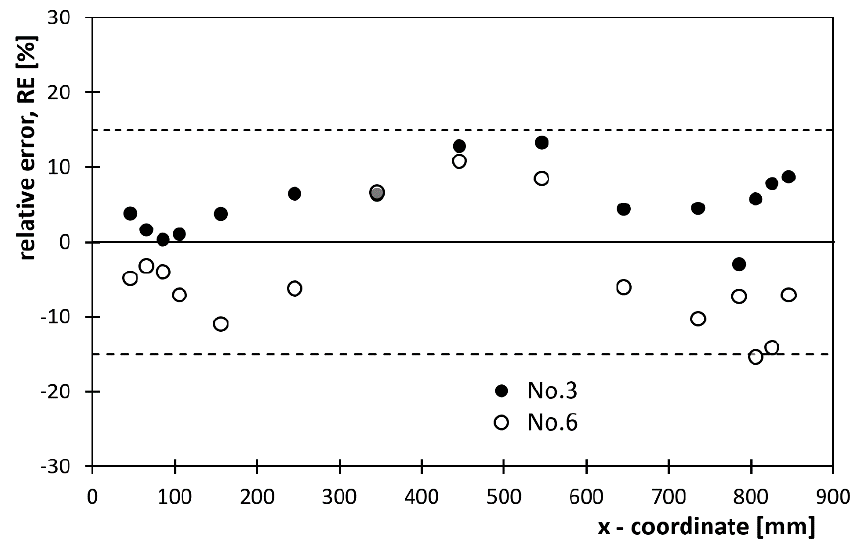
Figure 7. Relative error between numerical and experimental results shown in Figure 6 for meas-